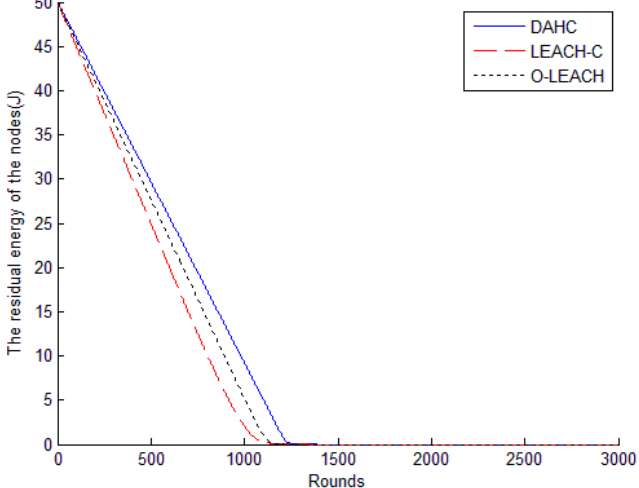
Figure 7. The residual energy of nodes versus rounds when the BS is inside.